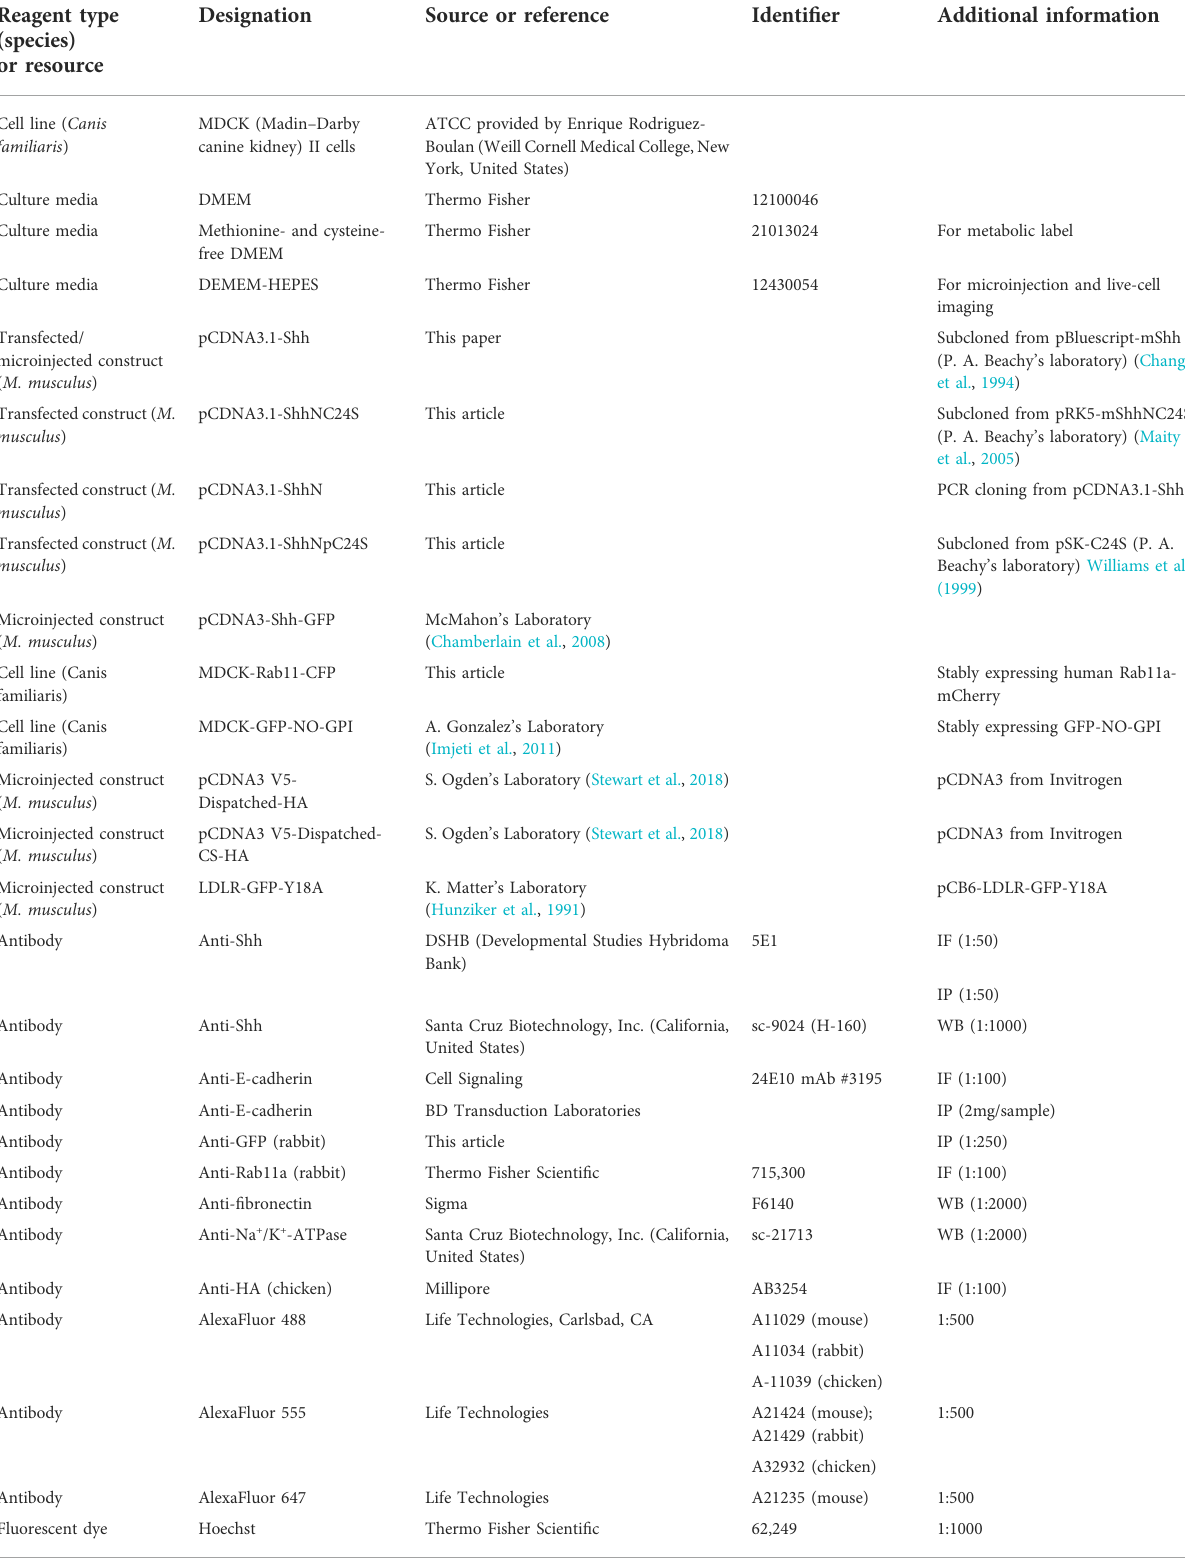
TABLE 1 Key resources